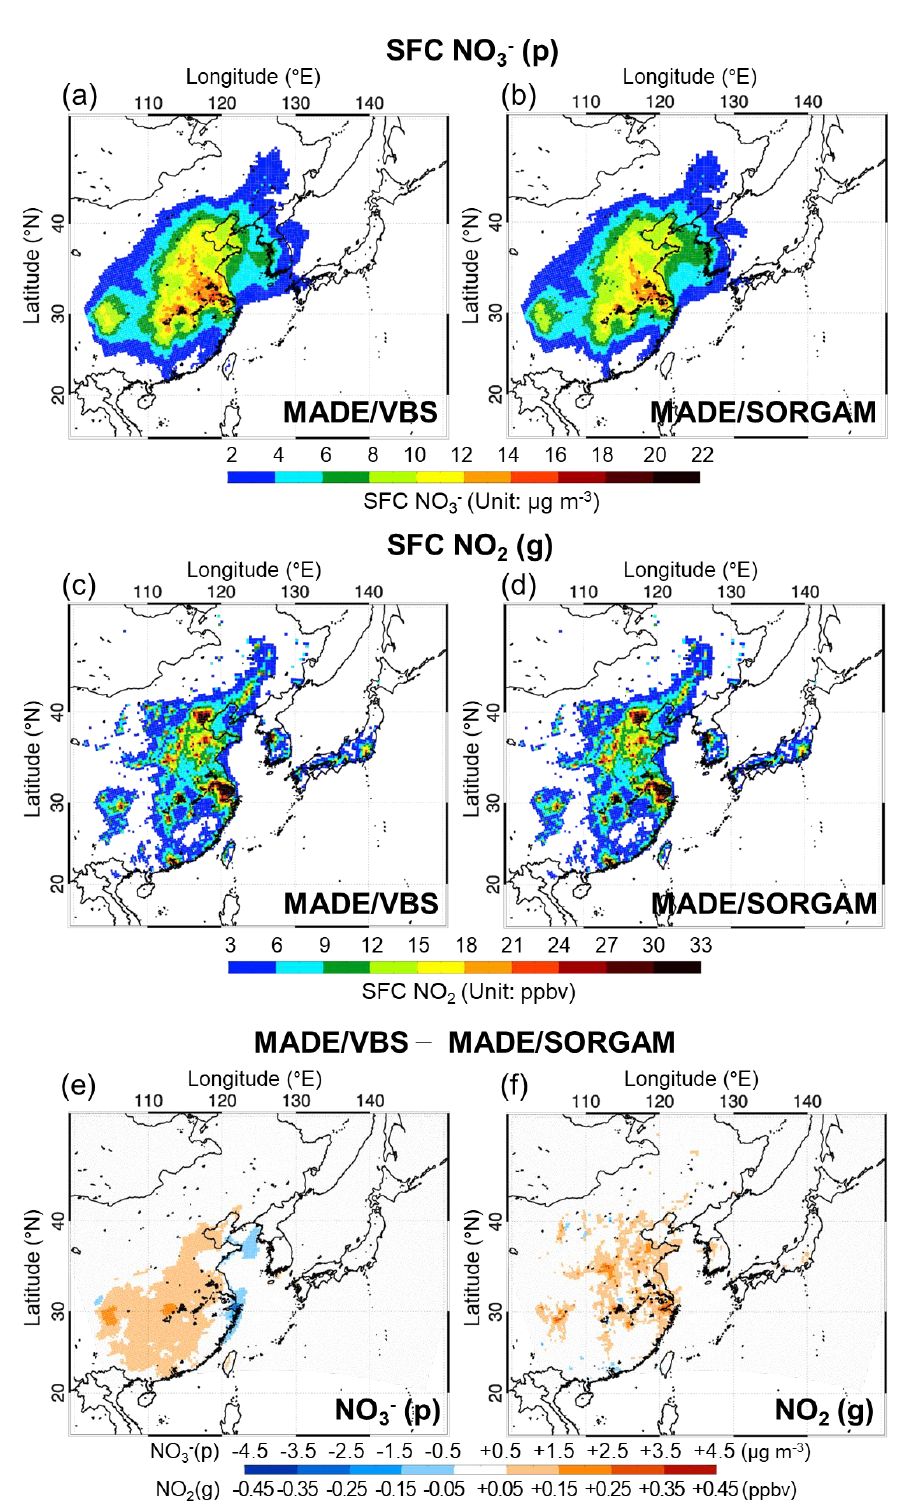
Figure 7. Comparisons of horizontal distributions for nitrate ( a , b ), NO 2 gas concentrations ( c , d ), and differences ( e , f ) between two modules, MADE/VBS and MADE/SORGAM, for nitrate (NO 3− ) and NO 2 , respectively.